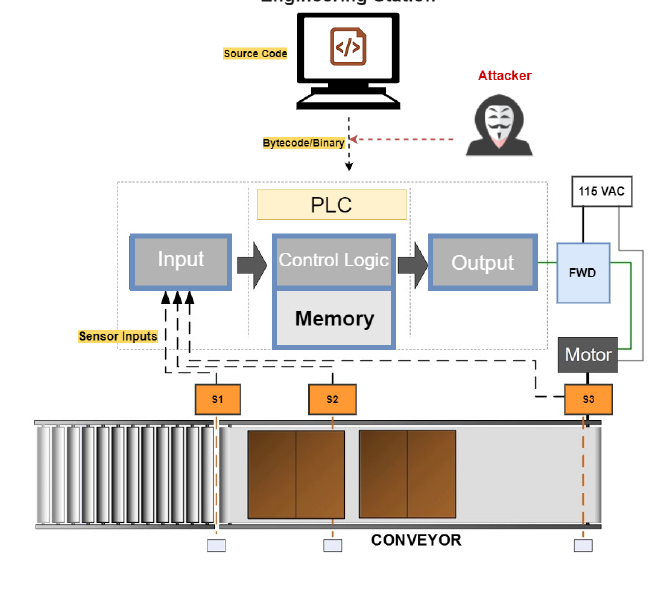
Figure 6. Attack scenario 2.